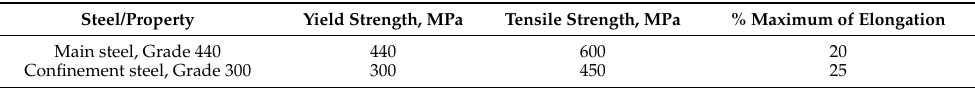
Table 2. Tension test results for main steel and confinement bars, according to the Egyptian Standard Specification, ESS, 262-2/2015, and ISO